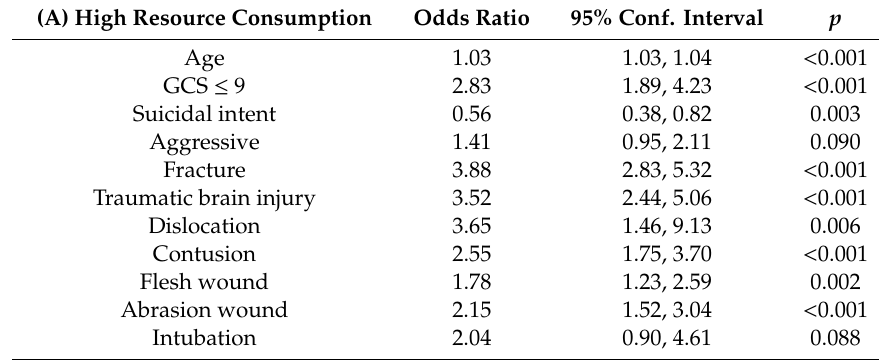
Table 4. ( A ) Predictors of high resource consumption through multivariate logistic regression and ( B ) predictors of total resource consumption though multivariate linear